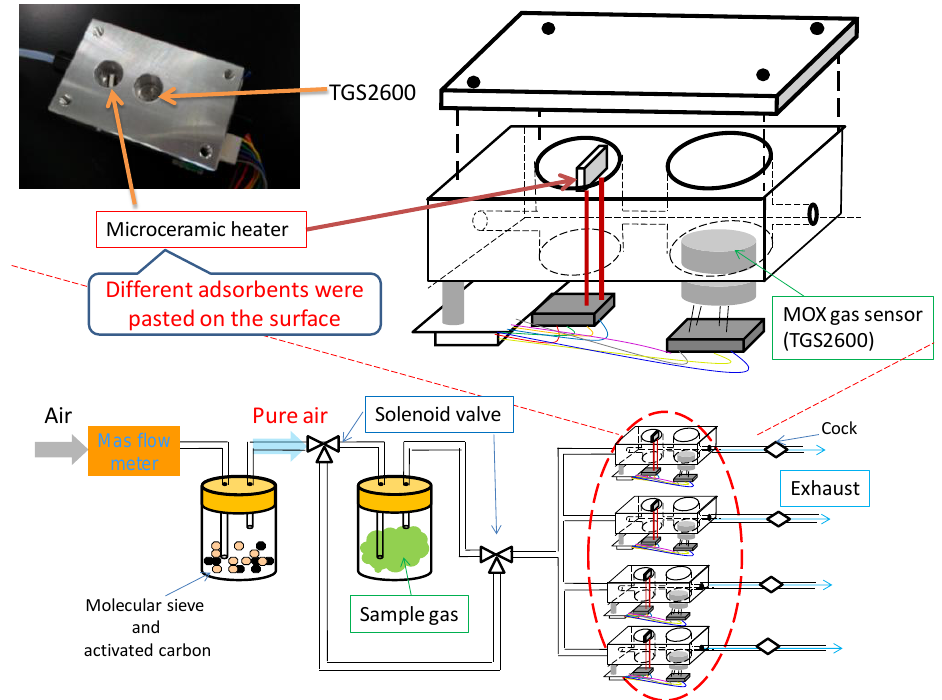
Figure 4. Illustration of the odor-separating